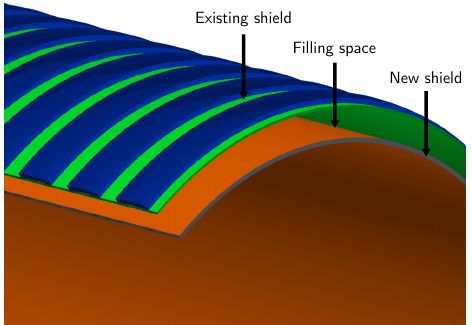
Figure 4. Alternative 1: Self-supporting lining with complete